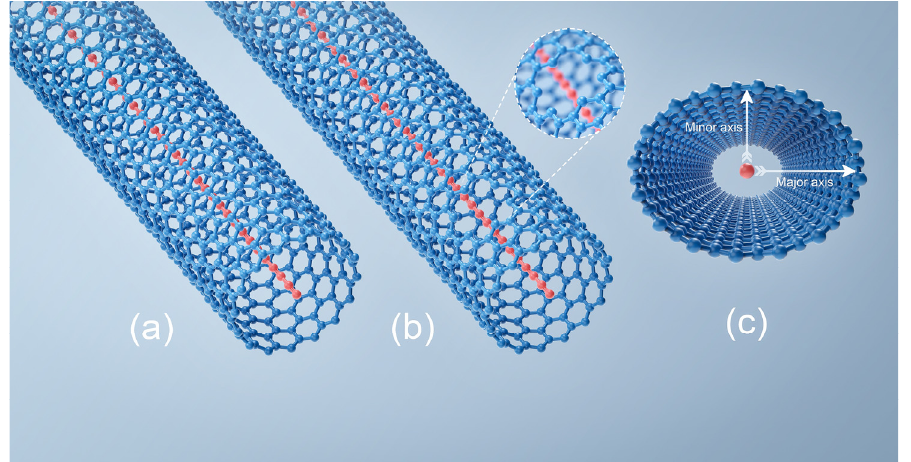
Figure 1. The carbon nanotube is marked by blue. The red internal chain refers to the carbyne. ( a )